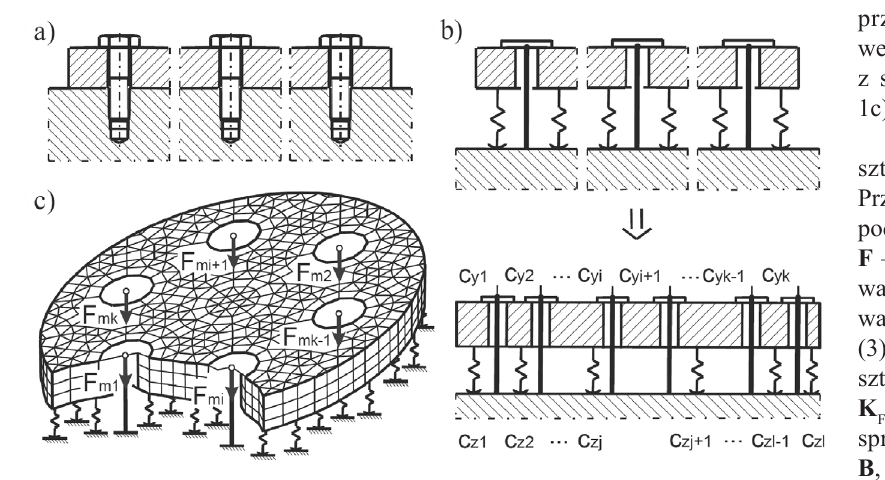
Fig. 1. Multi-bolted connection: a) diagram of the joint, b) description of the spring properties of the joint elements, c) FE-model of the joint